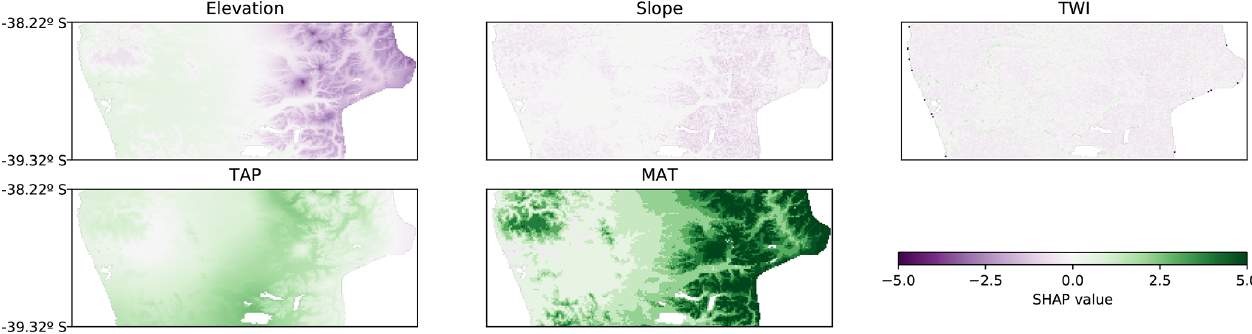
Figure 8. Spatial distribution of SHAP values for each covariate for the linear model (RMSE 3.8%). TAP: total annual precipitation; MAT: mean annual temperature; TWI: topographic wetness